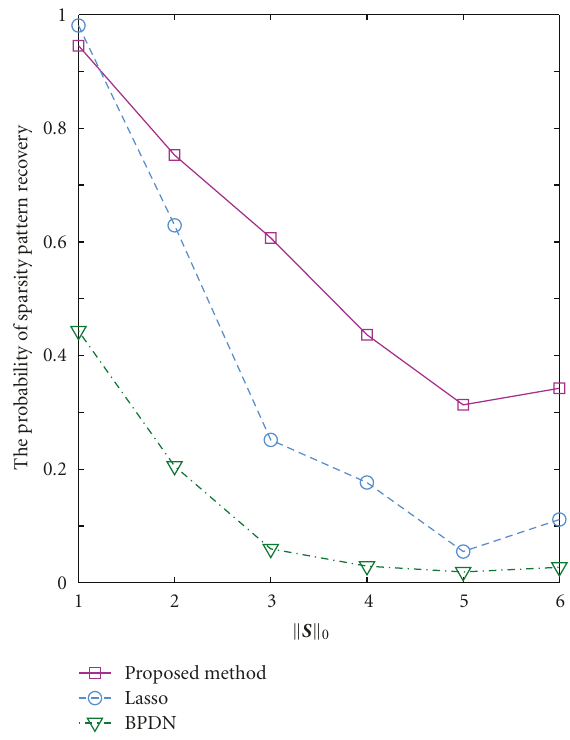
Figure 2: Comparison on the probability of sparsity pattern recovery.